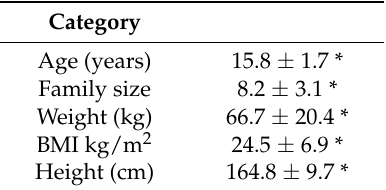
Table 1. Sociodemographic characteristics of the study